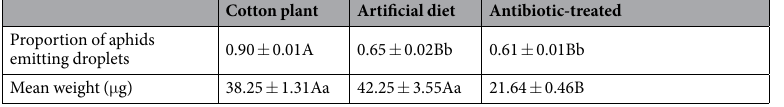
Table 3. Proportion of A. gossypii emitting cornicle droplets and mean weight of the aphids reared under different treatments. Data are mean ± SE. Different lowercase and uppercase letters within the same row indicate significant difference at 5% and 1% levels by using LSD multiple comparison method.